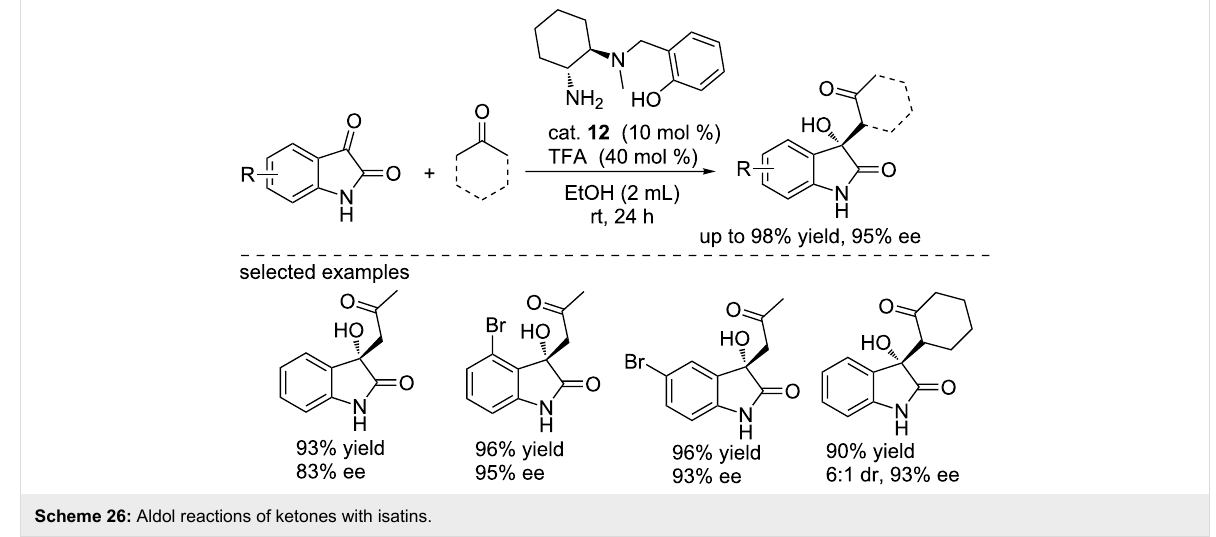
Scheme 26: Aldol reactions of ketones with isatins.